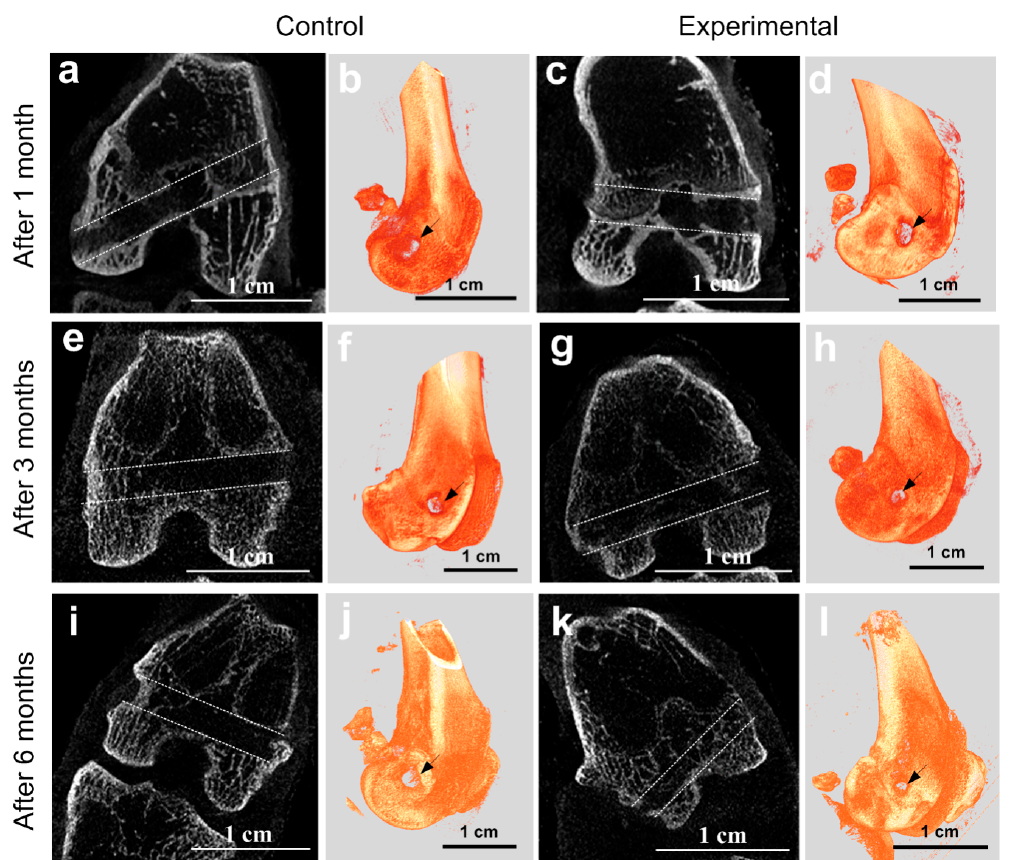
Figure 7. MicroCT projections ( a , c , e , g , i , k ) and three-dimensional images ( b , d , f , h , j , l ) of the transverse channel in the femur metaepiphysis for the control left and ( b , d , f ) experimental right knee joints through ( a , b ) 1, ( c , d ) 3, and ( e , f ) 6 months after implantation. All studies were conducted ex